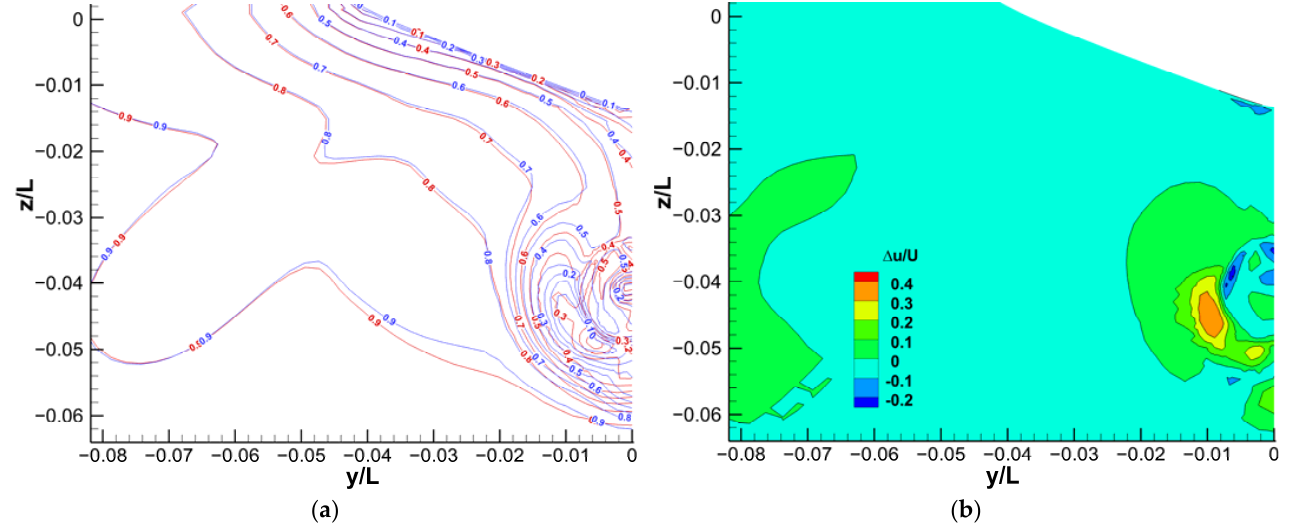
Figure 15. Comparison between 7 ° and 20 ° duct: ( a ) u/U contour lines: red for 7 ° and blue for 20 ° ; and ( b ) u/U difference of 7 ° and 20 ° duct.